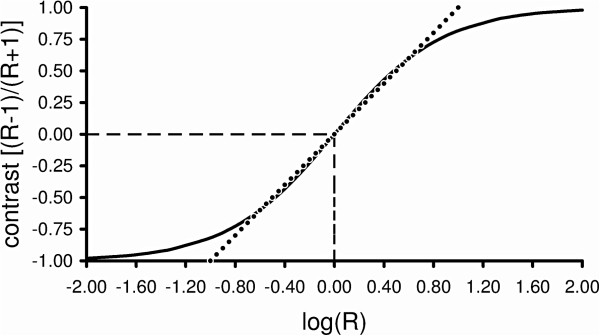
Contrast-value as a function of logarithmic value of the ratio between two score values (solid curve). Ratio R = S2/S1, in which S1 and S2 are the first and the second score value. When there is no difference between S2 and S1, both the Contrast-value and the value of log(R) are zero (hatched lines). When S2 is zero and S1 has a positive value, log(R) is undefined (infinite negative) whereas the Contrast-value is −1.0. When S2 has a positive value while S1 is zero, log(R) becomes undefined (infinite positive) whereas the Contrast-value is +1.0. If all Contrast-values were numerically identical to log(R) values, the relationship between Contrast and log(R) values would be depicted by he dotted straight line. Note that although not identical in general, Contrast and log(R) values are numerically similar (deviation with respect to the mean of both types of values < 15%) for a wide range of log(R) values on both sides of the zero point (range −0.80 to +0.80).